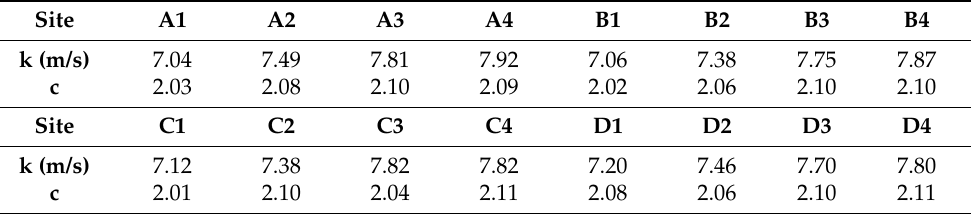
Figure 4. The Weibull distributions corresponding to the ERA5 values (January 1979 to December 2020). Table 3. Weibull characteristics corresponding to locations considered. The results are reported for the U 100 parameter for the time interval from January 1979 until December 2020.